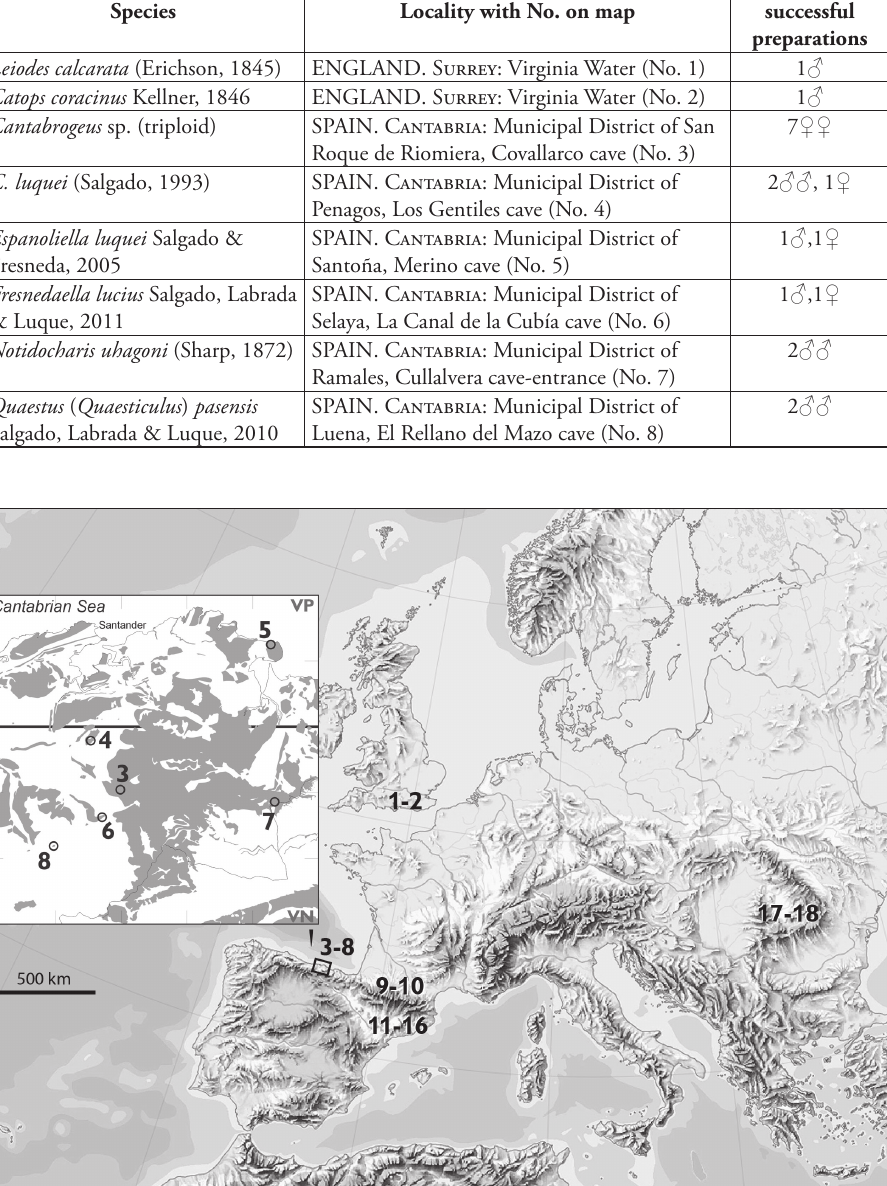
table 1. Material used, localities, map numbers, numbers of specimens giving successful preparations. Species